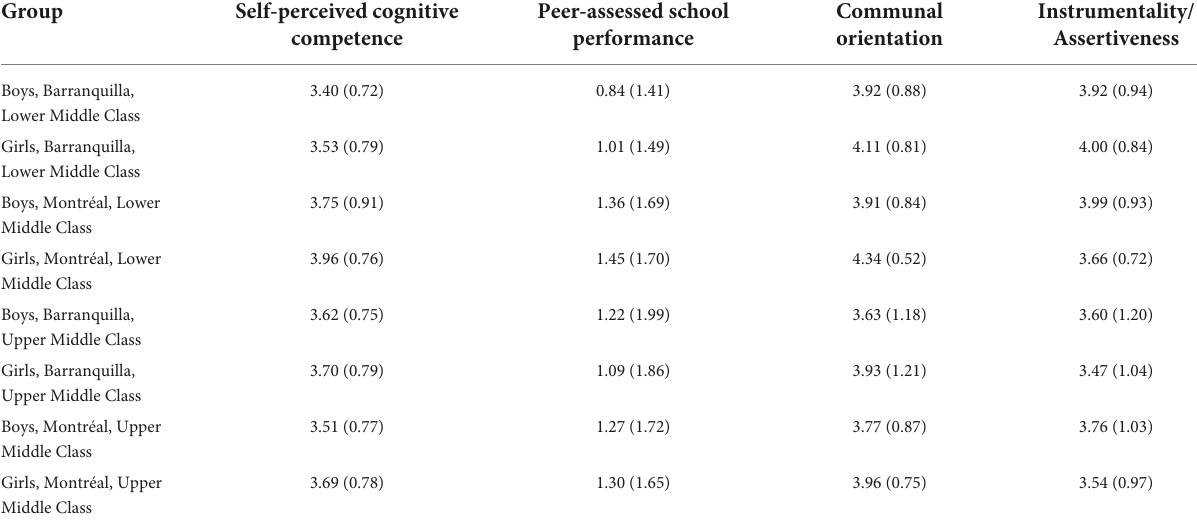
TABLE 1 Means (standard deviations) for person-level variables for groups defined by participant gender, SES, and place.